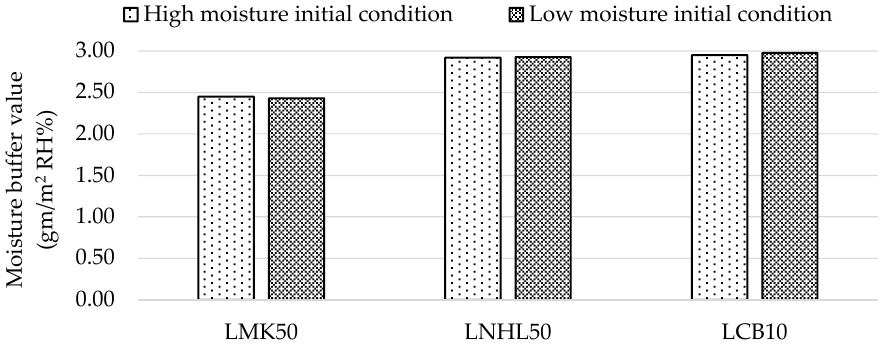
Figure 7. Average steady-state moisture buffer value (MBV).